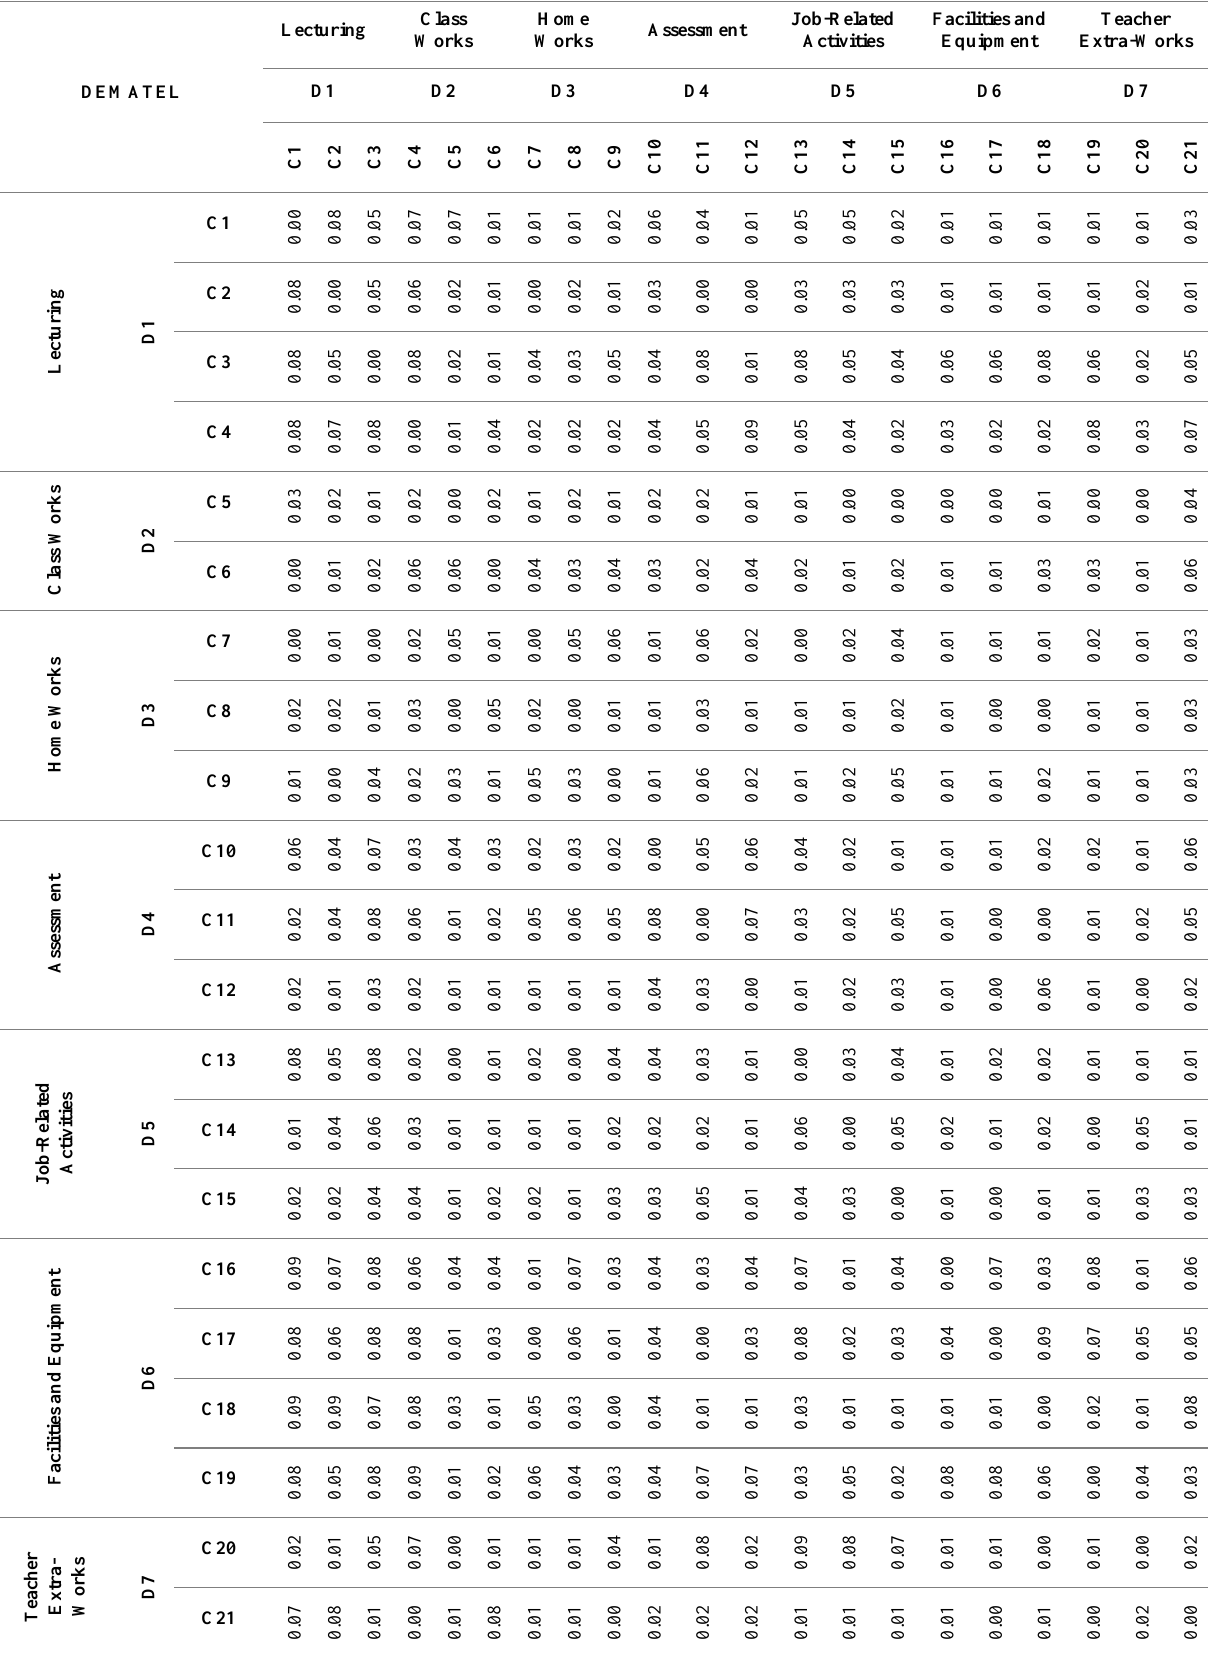
Table 8. Normalized matrix A (matrix